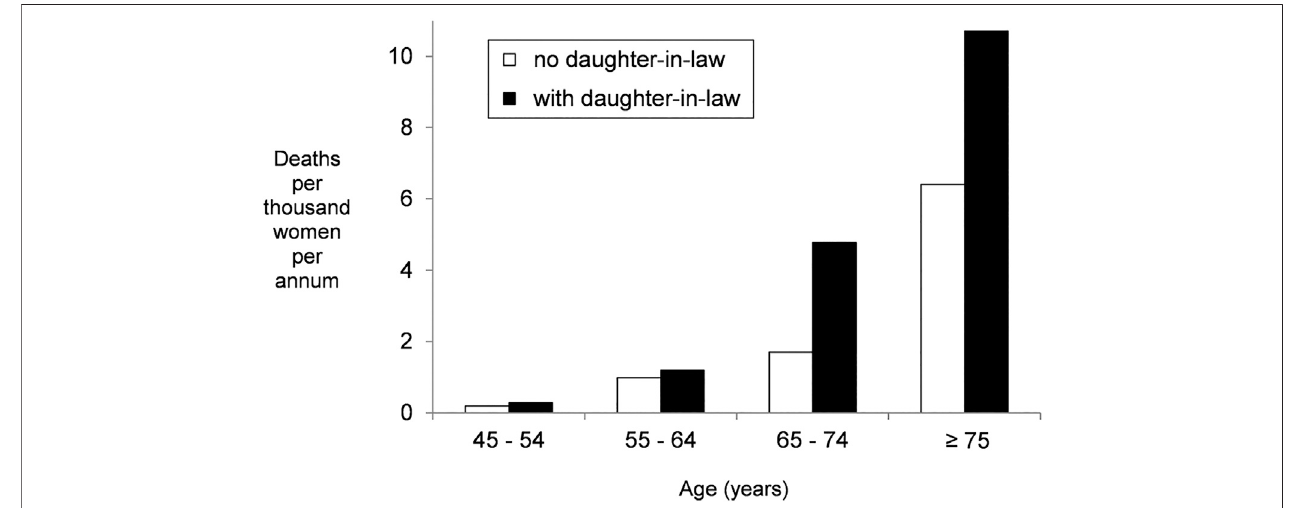
FIGURE 1 | Annualized mortality rates of women with and without co-residing daughters-in-law, based on the 10% sample.